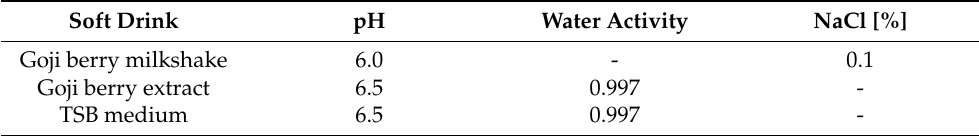
Table 2. Chemical parameters of goji berries milkshake, goji berries extract, and TSB medium. Soft Drink pH Water Activity NaCl [%] Goji berry milkshake 6.0 - 0.1 Goji berry extract 6.5 0.997 - TSB medium 6.5 0.997